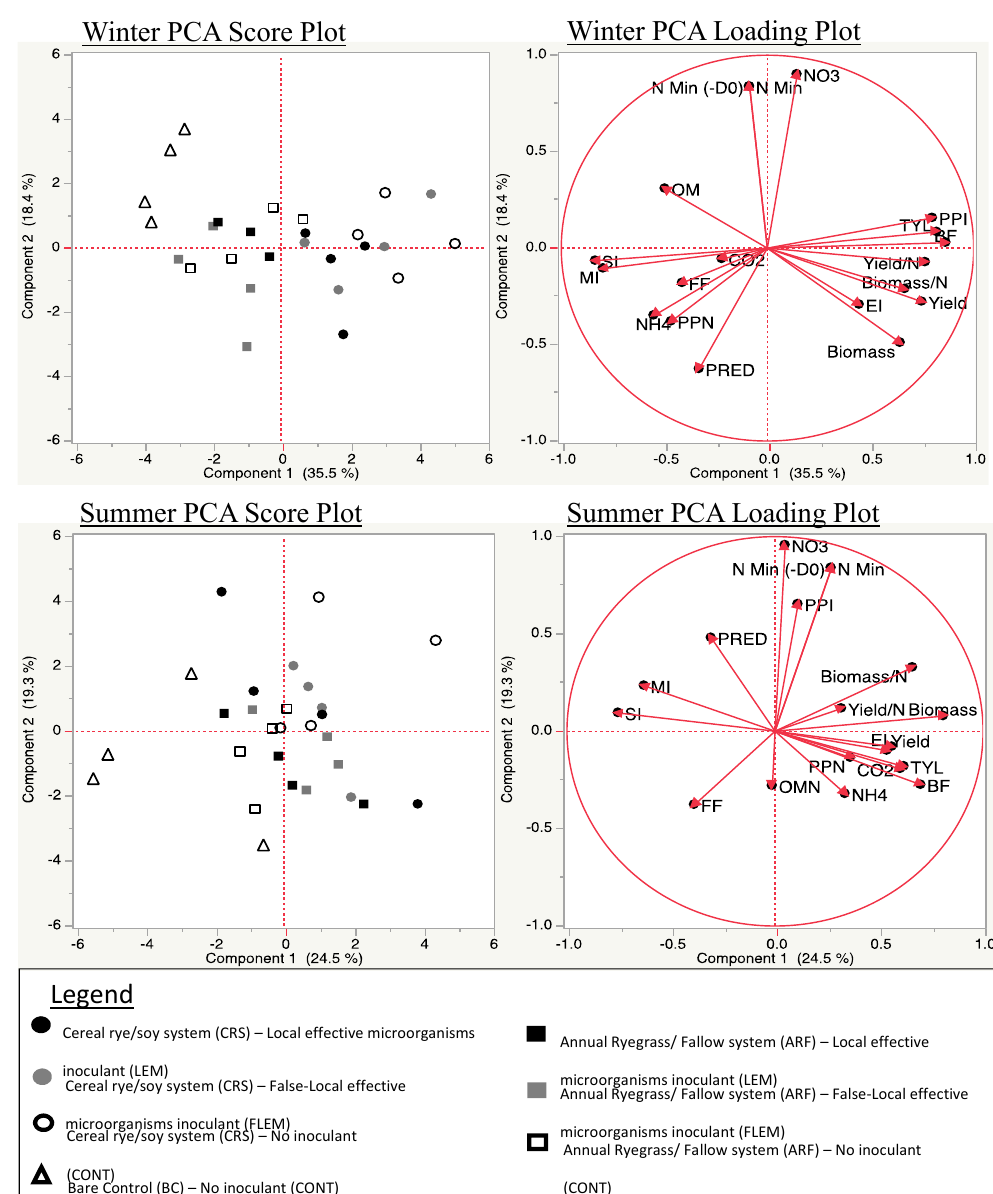
Figure 4. Triangles, squares and circles represent BC, ARF and CRS rotations, respectively. Black, gray and open symbols represent LEM, FLEM and CONT treatments, respectively. Variable abbreviations: NO 3 (nitrate present after 1 month incubation), NH 4 (ammonium present after 1 month incubation), N Min (inorganic N present after 1 month incubation), N Min (-D0) (Nitrogen mineralized during 1 month incubation), CO 2 (CO 2 –C respired 3 days after rewetting dried soils), Biomass / N and Yield / N (biomass and yield reported as a proportion of N present in soil after treatment application), BF (bacterial-feeding nematodes), FF (fungal-feeding nematodes), PPN (plant parasitic nemaotdes), TYL (nematodes in the Tylenchidae family), OMN (omnivorous nematodes), PRED (nematodes that predate on mesofauna, including other nematodes). Shown above are principal component analysis score plot and loading plot for the soil health indicator values measured in the